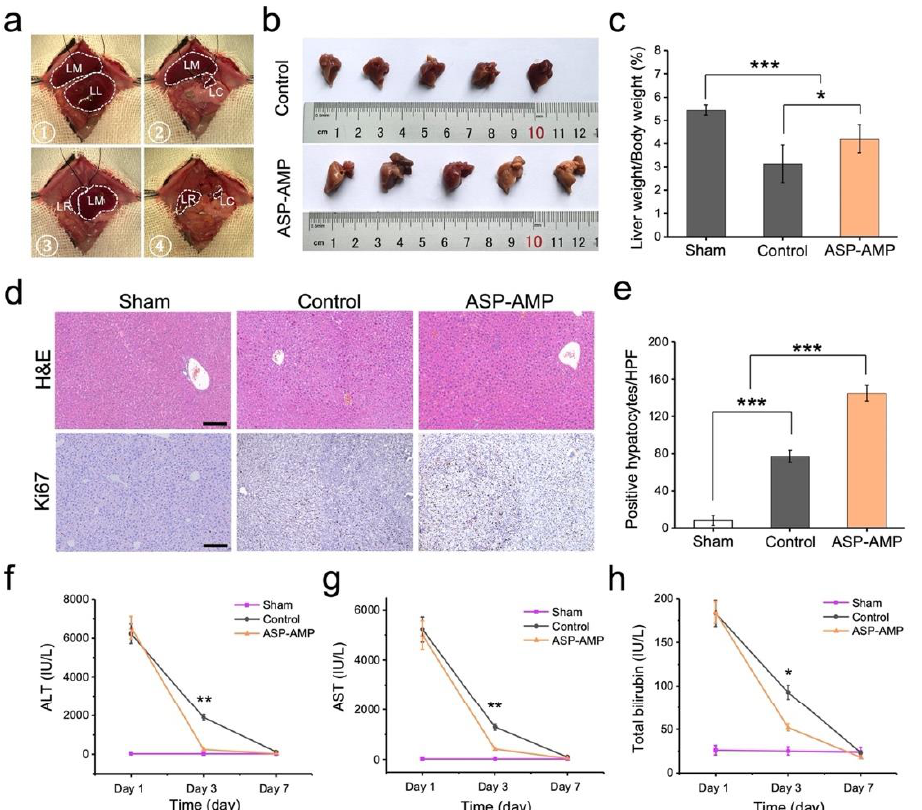
Figure 3. ASP-AMP enhanced liver regeneration after partial hepatectomy. ( a ) Schematic represen- tation of 70% hepatectomy in mice. ( b ) The view of isolated liver tissues at day 7 ( n = 5). ( c ) Ratio of liver weight to body weight 7 days after hepatectomy ( n = 5). ( d ) Representative H&E and Ki67 staining of liver sections 3 days after hepatectomy (scale bar = 200 µm). ( e ) The quantification of Ki67 staining of liver sections 3 days after hepatectomy. Plasma ALT ( f ), AST ( g ), and total bilirubin ( h ) levels in mice 1 day, 3 days, and 7 days after hepatectomy with ASP-AMP intervention ( n = 3). LM, liver middle lobe; LL, liver left lobe; LR, liver right lobe; LC, liver caudate lobe. ALT, alanine aminotransferase; AST, aspartate aminotransferase. * p < 0.05, ** p < 0.01, and *** p < 0.001.